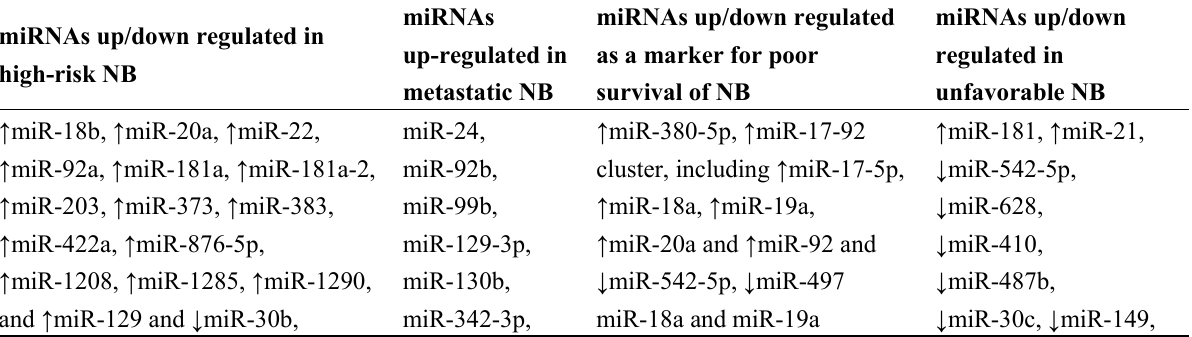
Table 2. Clinical relevance of miRNAs in NB